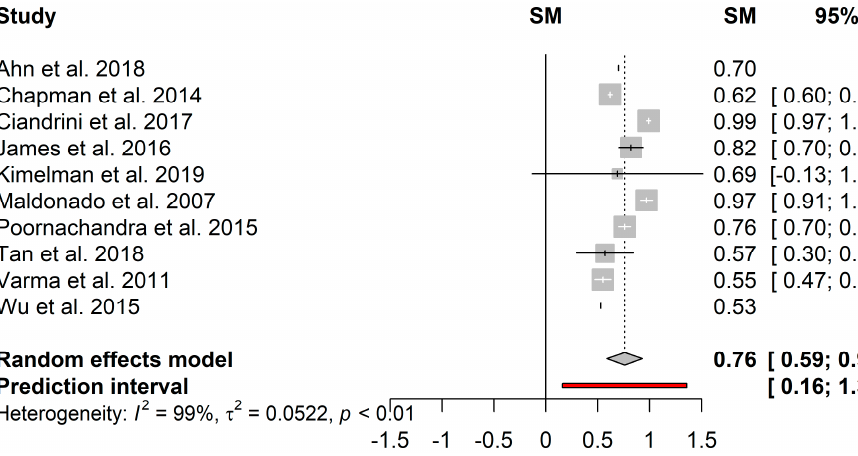
Figure 7. Forest plot of the pooled effect estimates for the proportion of biofilm reduction induced by cell-free supernatants. The vertical dashes represent the effect estimate, and the horizontal line is the respective confidence interval at 95% (95%–CI) obtained for each study. Gray squares represent the standard deviation of each study, while the gray diamond represents the pooled effect estimates. The red bar represents the predictive interval. Heterogeneity test: I 2 – I 2 test; τ 2 –Tau-squared test.